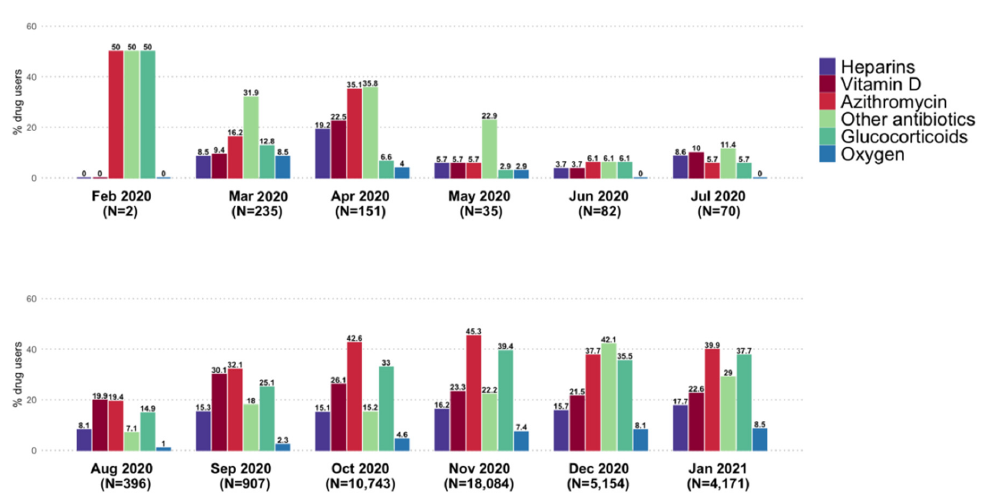
Figure 2. Frequency (%) of the study drug/drug class use in COVID-19 patients from Caserta Local Health Unit in the period 1 February 2020–31 January 2021, stratified by calendar month.